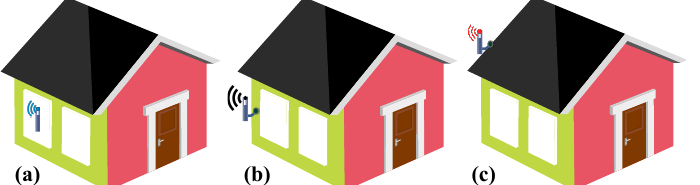
Figure 19. Terminal antenna placement: ( a ) indoor window sill, ( b ) exterior window/wall-mounted, and ( c )